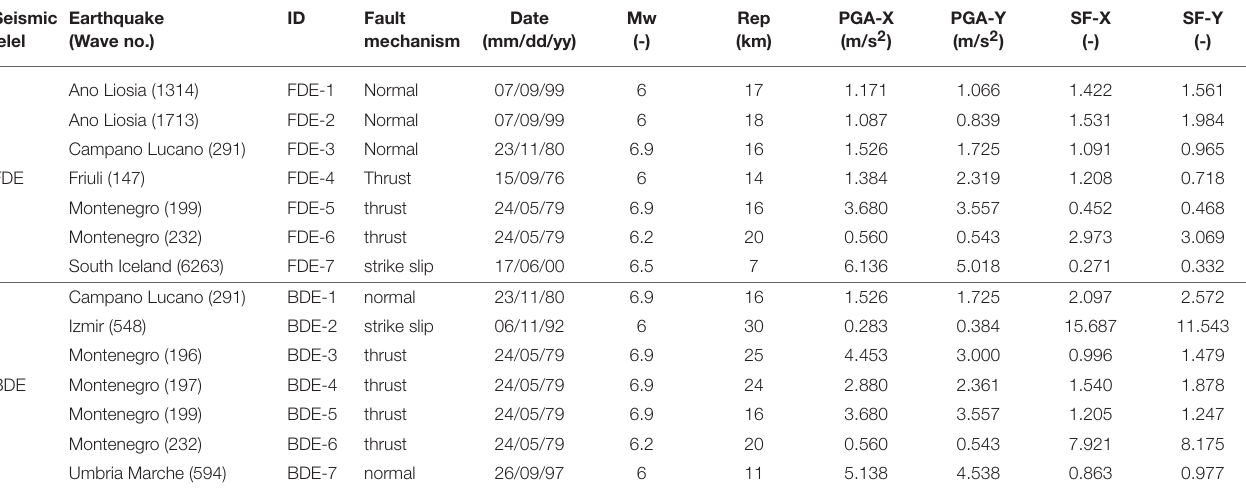
TABLE 2 | Ground motion records for seismic analyses at FDE and BDE. Seismic Earthquake lelel (Wave